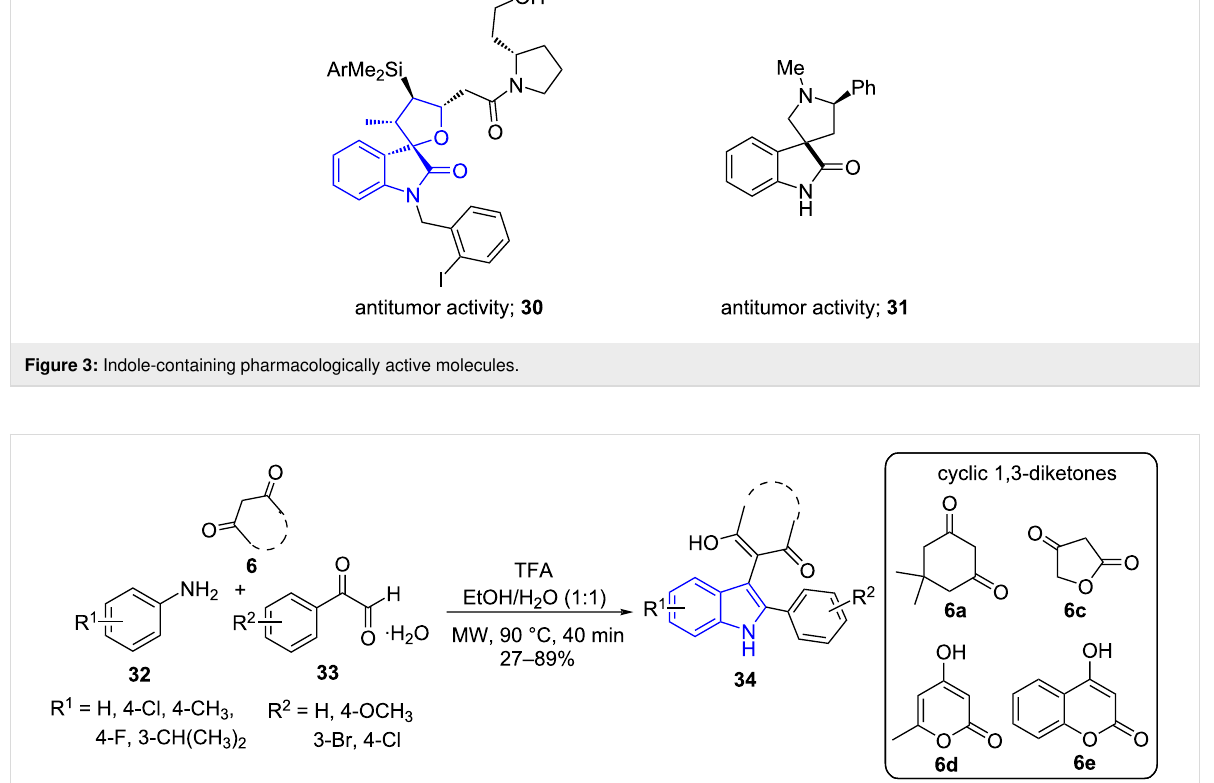
Scheme 10: Synthesis of functionalized